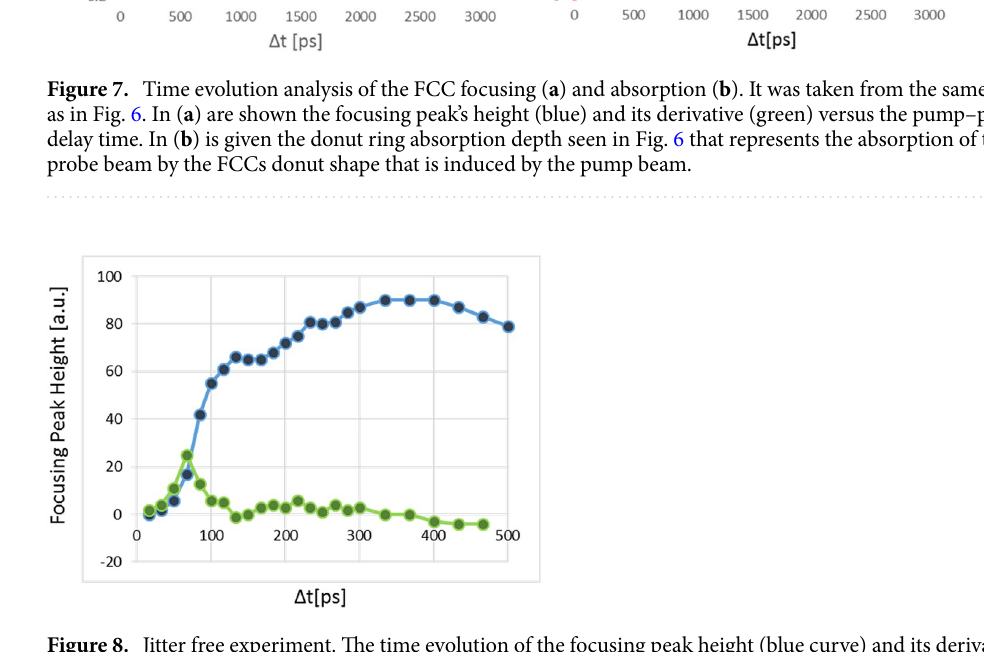
Figure 8. Jitter free experiment. The time evolution of the focusing peak height (blue curve) and its derivative (green curve) on time-region below 500 ps (the first region) are shown. The 30 ps pump pulse applied at Δt = 0. The sharp rise at the first 100 ps is due to FCCs build-up induced by the pump pulse. Above 100 ps the increase in the focusing peak height is due to the slow ambipolar diffusion of the FCCs towards the donut center where the best focusing appears at Δt ≈ 350